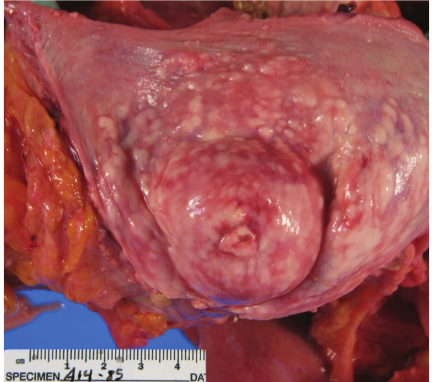
Figure 8: Tumor infiltrating surface of exocervix and